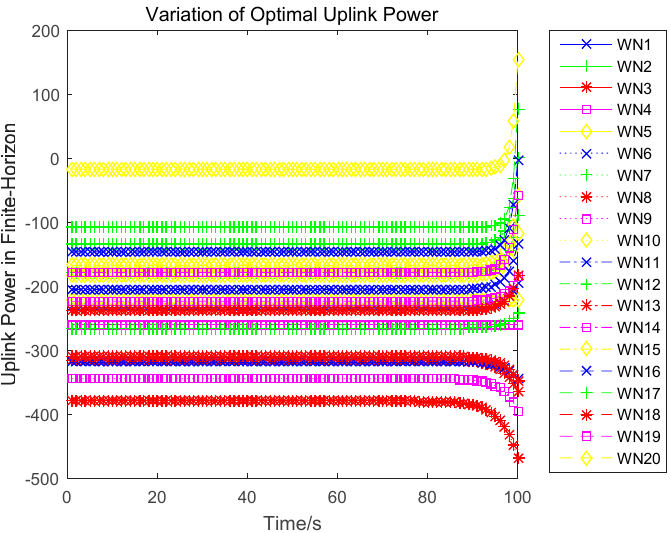
A t with time. i